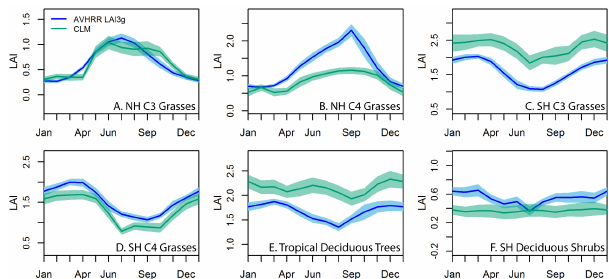
Figure 2. Annual LAI cycles for LAI3g and CLM averaged for 1982–2010; shaded areas represent one standard deviation. Each plot is averaged across a region as shown in Fig. 1. (a) Northern Hemisphere (NH) C3 grasses; (b) NH C4 grasses; (c) Southern Hemisphere (SH) C3 grasses; (d) SH C4 grasses; (e) Tropical de- ciduous trees; (f) SH broadleaved deciduous